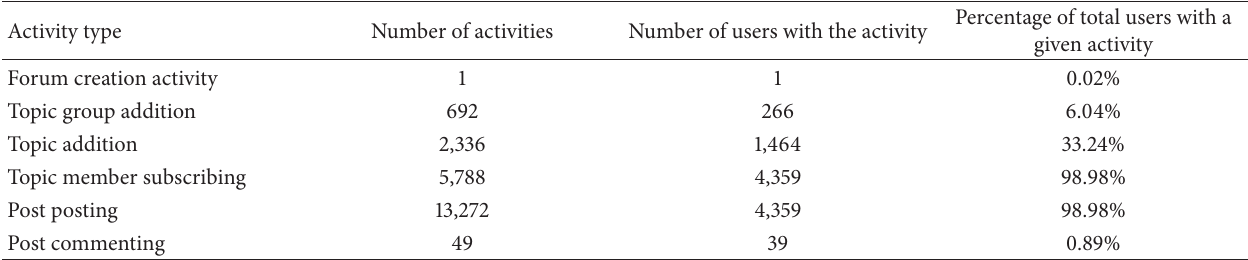
Table 3: Activities in the hierarchical presocial network.